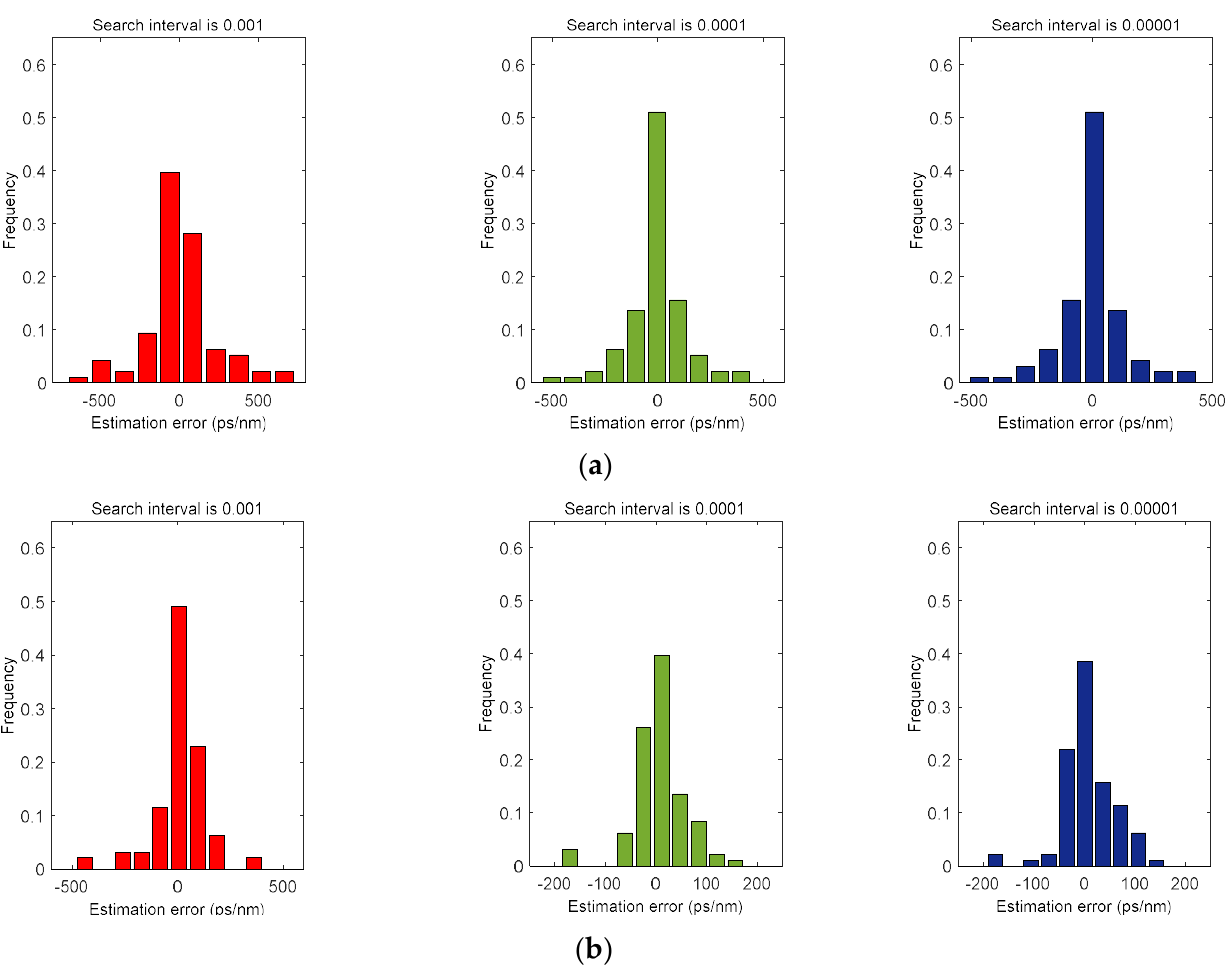
Figure 9. CD estimation error distribution of PM-16QAM signal corresponding to different search intervals when the sampling points are ( a ) 2048 and ( b ) 4096. Table 3. CD estimation performance under different sampling points and search interval (ps/nm).